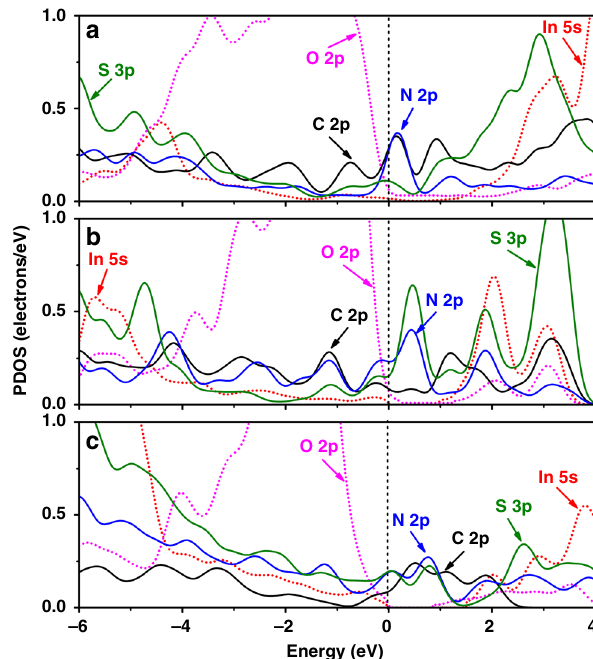
Fig. 8 Density functional theory calculations. PDOS for a In 2 O 3 (100) face/ N,S-codoped graphite (001) face, b In 2 O 3 (110) face/N,S-codoped graphite (001) face, and c In 2 O 3 (111) face/N, S-codoped graphite (001) face